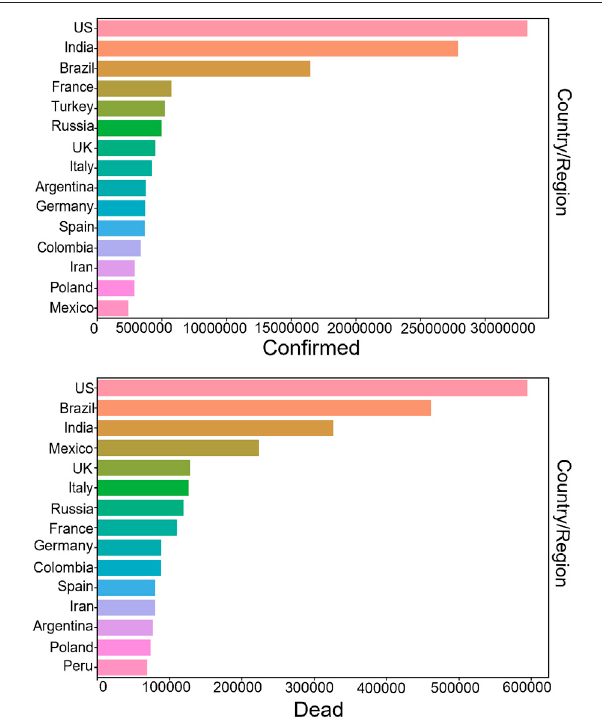
FIGURE 2 | Top 15 countries with cumulative con fi rmed cases and deaths.Con fi rmedcasesareshownabove,anddeathsareshownbelow.The United States, India and Brazil are the top three, with the United States having the most cumulative con fi rmed cases and